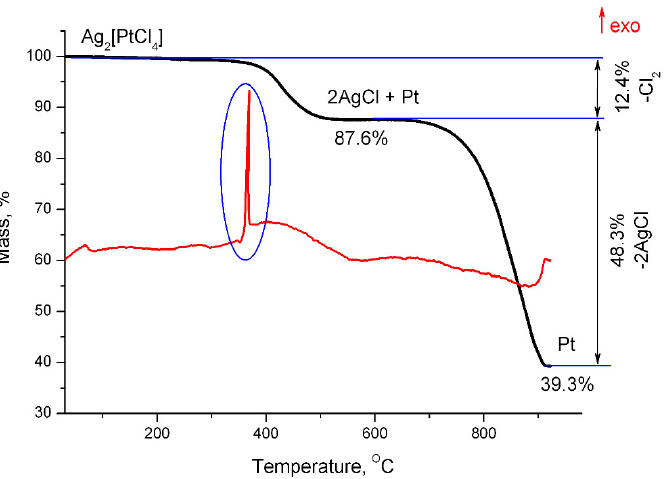
Figure 1. Mass loss curves and differential thermal analysis of Ag 2 [PtCl 4 ] in a helium atmosphere. It is noteworthy that intense heat is released at a temperature of 365 ◦ C (at the very beginning of the decomposition of the initial compound) which could be associated with a phase transition or another process that is not accompanied by a change in